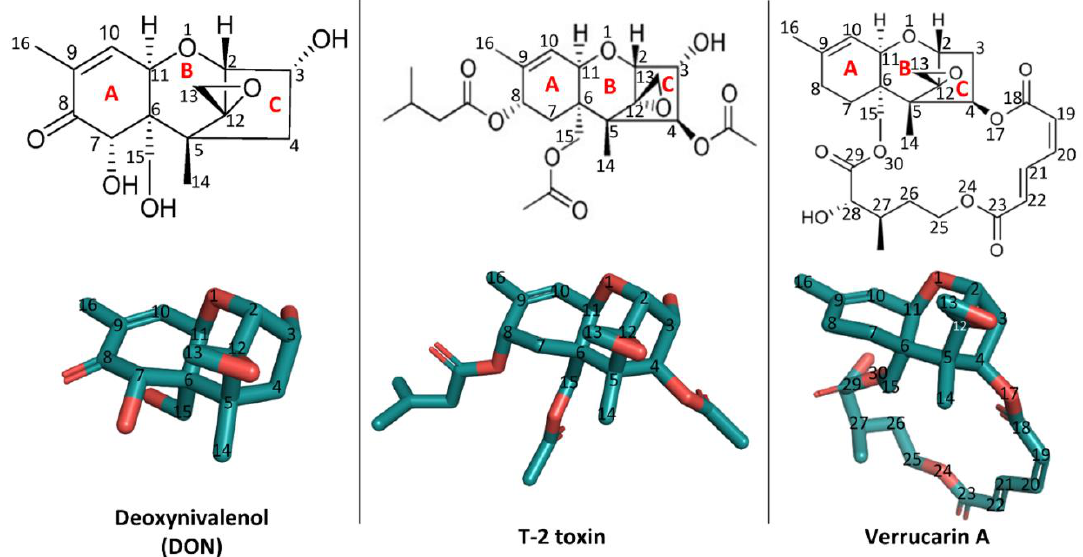
Figure 1. The two-dimensional and three-dimensional structures of deoxynivalenol (DON), T-2 toxin, and verrucarin A and their position numbering. The three-dimensional structures were visualized using PyMOL 2.3.4. The PDB accession number of DON is 3J6, those of T-2 toxin and verrucarin A are 3 L2 and ZBA,